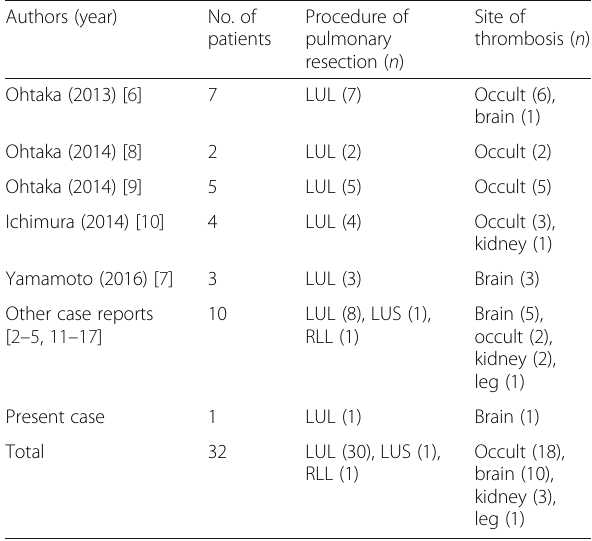
Table 1 Reported cases of thrombus formation in the pulmonary vein stump after pulmonary resection